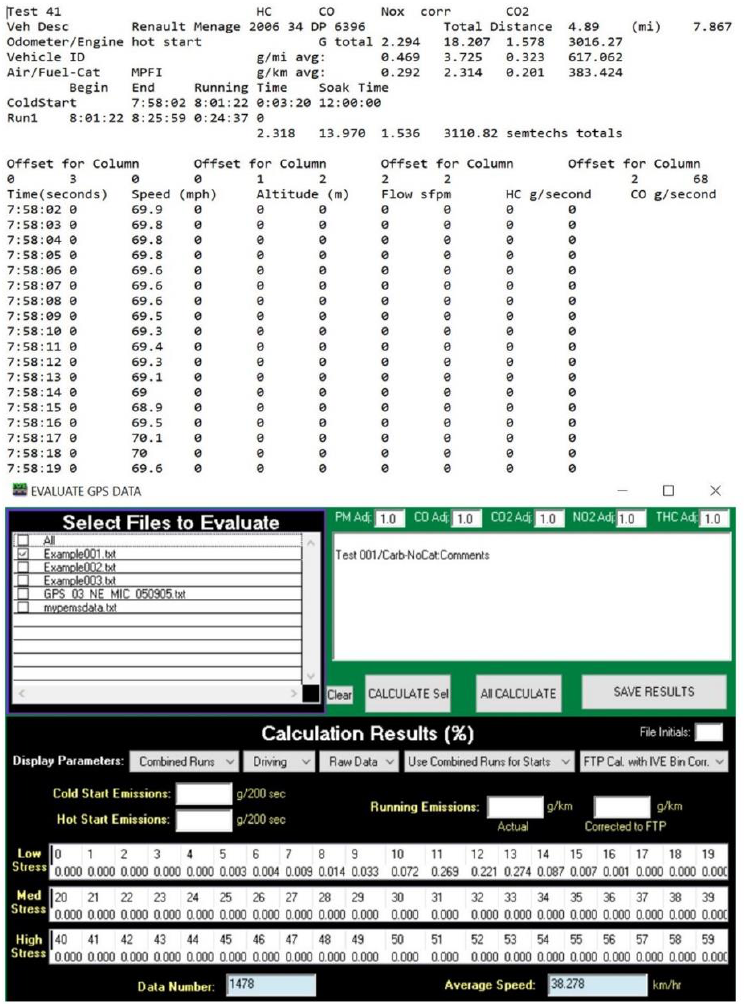
Figure 5. An example of the spreadsheets for the “bin” generation. Banking on these datasets, it was possible to run iGREEN 108 times for each trialed route, accounting for 1404 simulations, from which the emission packages were further